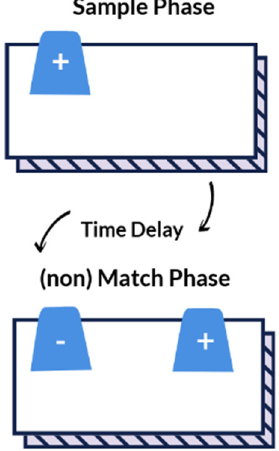
Figure 2. Schema of the delayed non-match to position test.